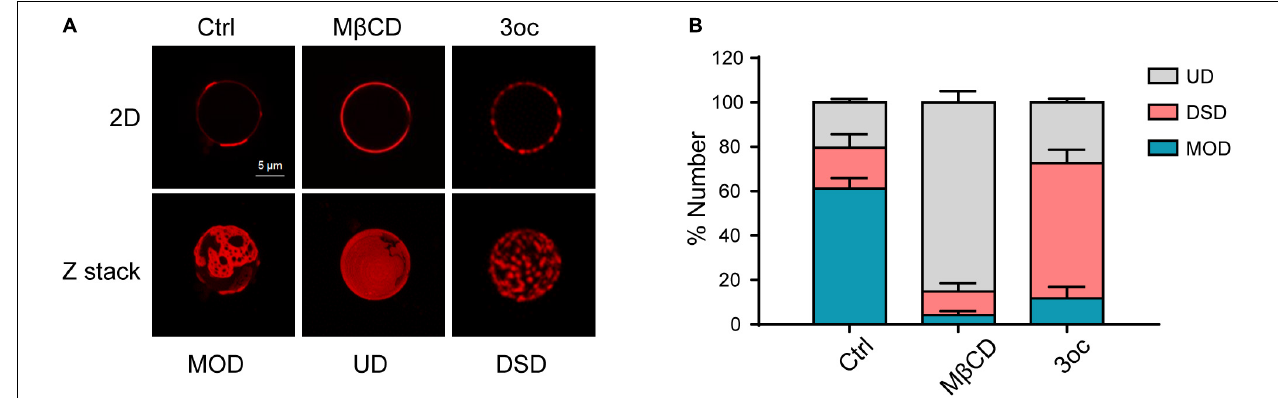
FIGURE 1 | Characterizing the effects of methyl- β -cyclodextrin (M β CD) and N -(3-oxo-dodecanoyl) homoserine lactone (3oc) treatments on lipid-ordered domain on giant plasma membrane vesicles (GPMVs). (A) The upper panels show the distribution of ordered domains at the maximum diameter of GPMVs. Images from left to right are control, M β CD (10 mM), and 3oc (10 µ M) treatments. The lower panels are the corresponding Z-stack images. (B) Statistical results show that mixed ordered and disordered (MOD) (59%) dominates the untreated GPMVs, M β CD, and 3oc treatment preferentially resulted in uniform disordered (UD) (86.6%) and disintegrated small domain (DSD) (63.05%), respectively. This experiment was repeated three times, each with 40–50 vesicles per condition. Scale bar = 5 µ